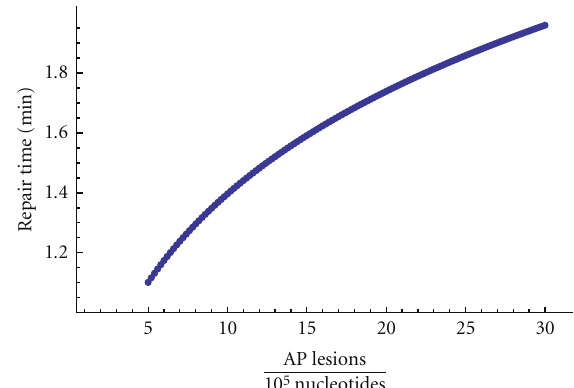
Figure 3: Stage 2 mathematical model of BER. The plot shows the time required to repair a fixed number of AP sites per 10 5 nucleotides with wild-type BER enzymes. The horizontal axis represents the starting number of AP sites per 10 5 nucleotides and the vertical axis the time for this number of sites to be